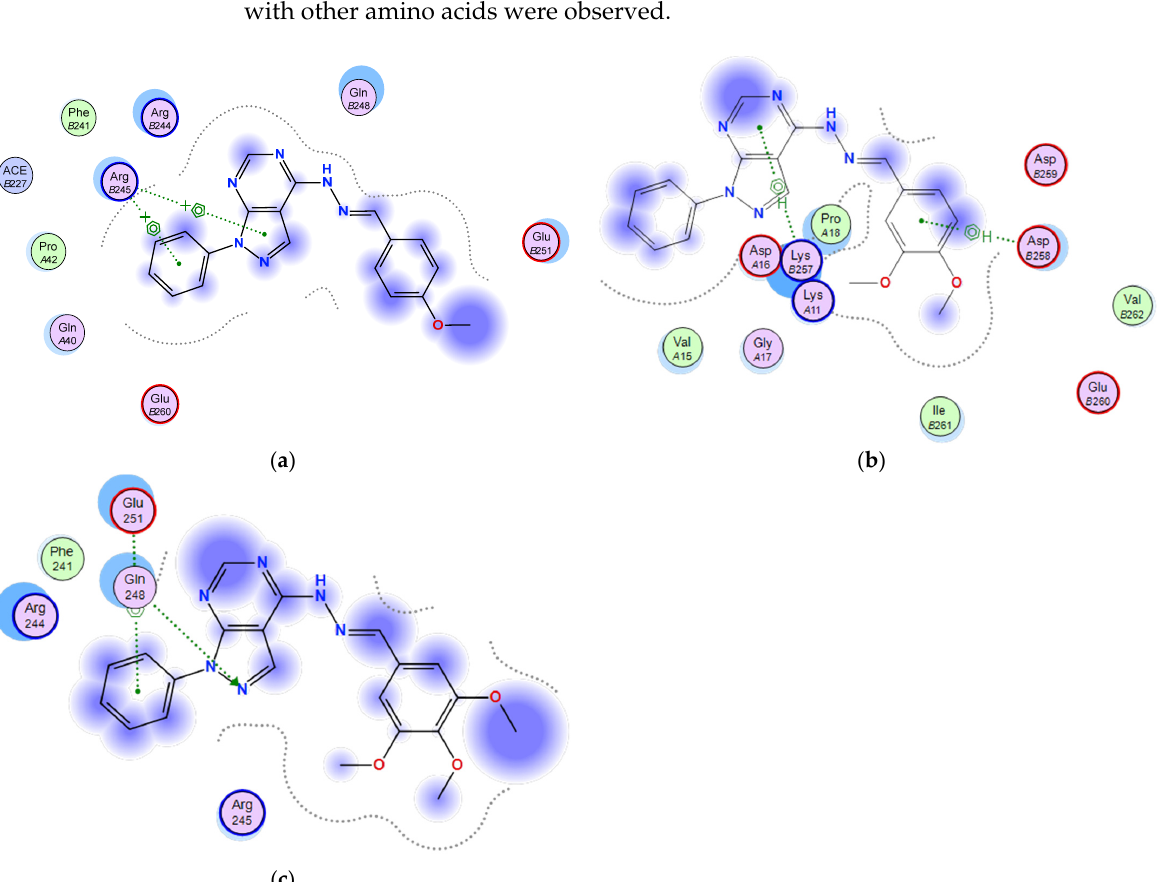
Figure 3. Two-dimensional binding mode of the test compounds ( a ) 6 , ( b ) 5 , and ( c ) 7 in the binding site of Ki67 protein (PDB ID: 2aff) using MOE software.